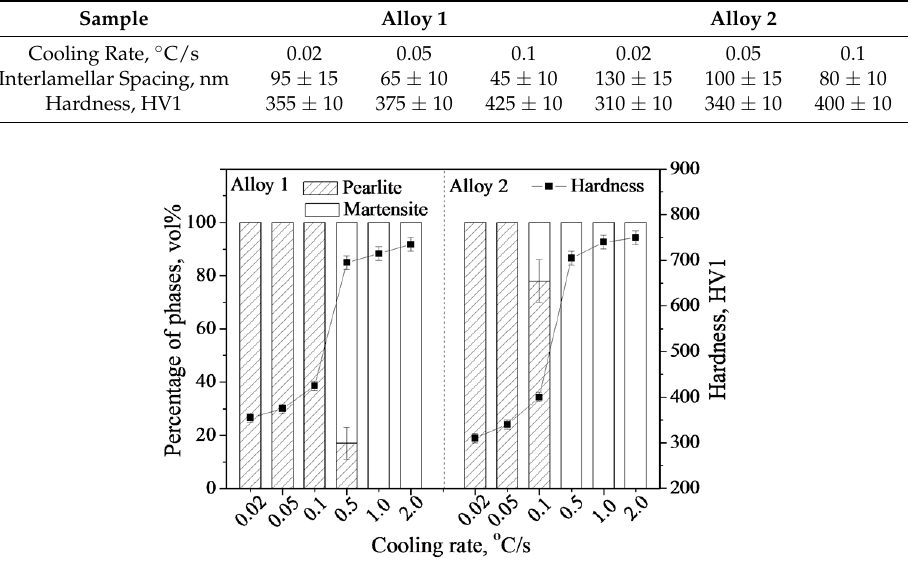
Figure 6. The phase fraction and hardness of the tested steels at different cooling rates.